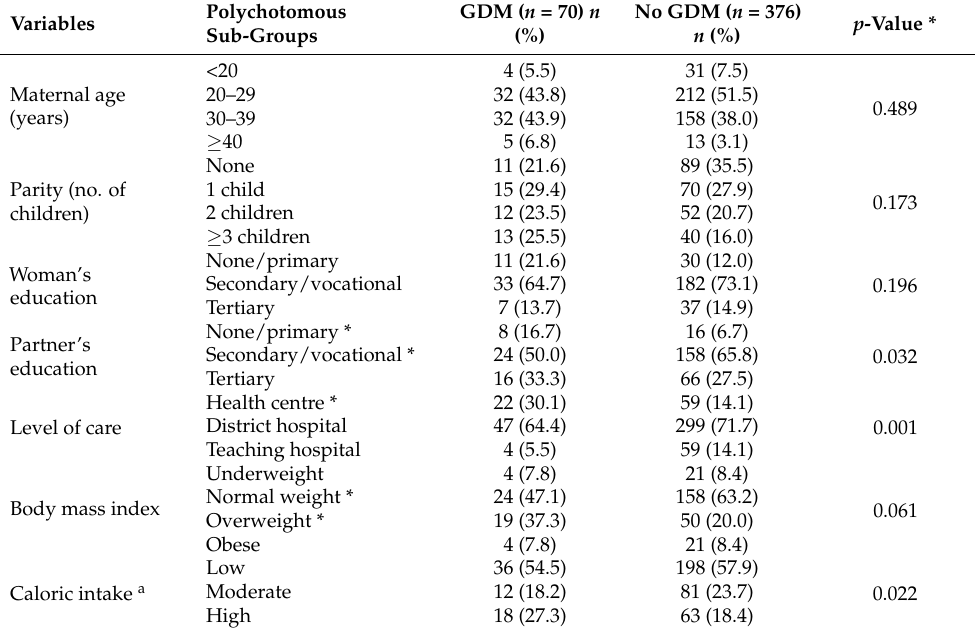
Table 2. Characteristics of the GDM positive and negative reference